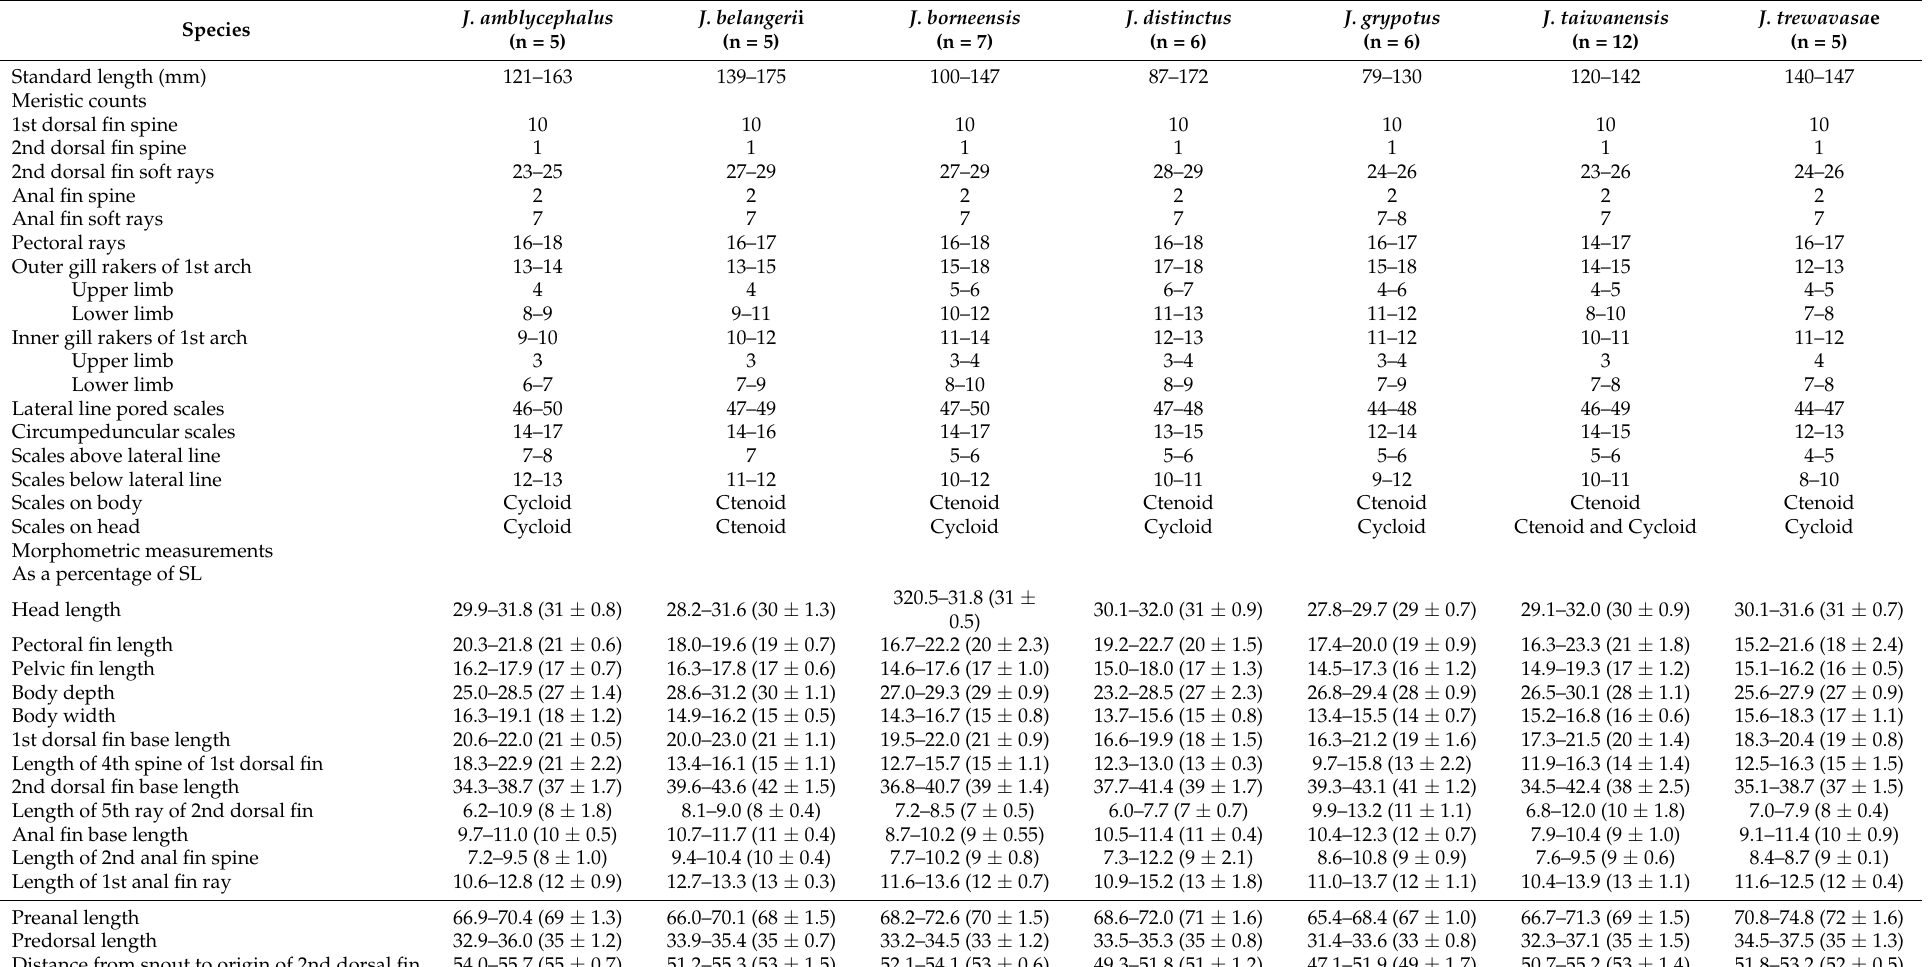
Table 6. Morphometric measurements and meristic counts of J. amblycephalus , J. belangerii , J. borneensis , J. distinctus , J. taiwanensis , J. trewavasae , and J. grypotus